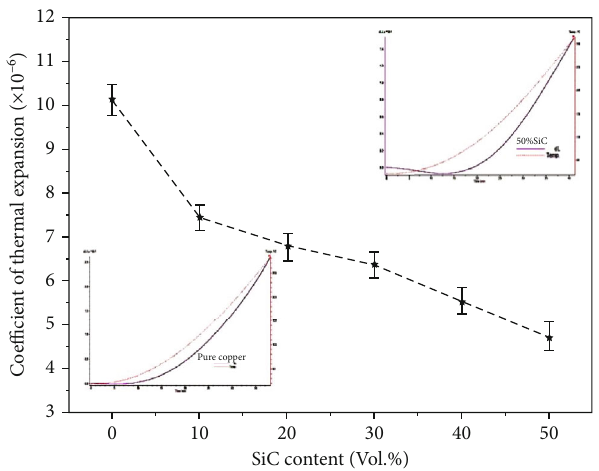
Figure 9: Relation curve between the SiC@Cu fraction and CET of SiC@Cu/Cu